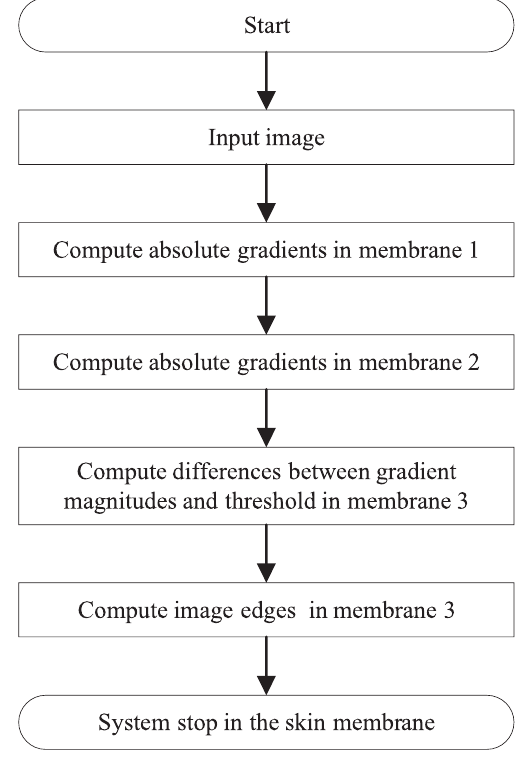
Figure 1. The flowchart of